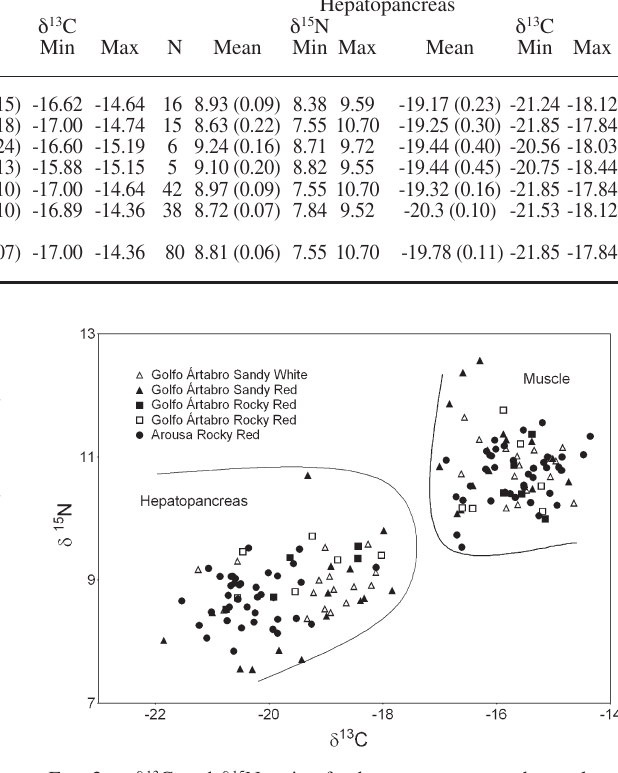
Fig . 2. – δ 13 C and δ 15 n ratios for hepatopancreas and muscle of juvenile spider crabs Maja brachydactyl a in the ria de arousa and Golfo artabro. Substrate type of capture area and body colour are indicated. Table 4. – results of anoVas (F-statistic and probability level in parenthesis) used to test differences in δ 15 n and δ 13 C values in the muscle and hepatopancreas of Maja brachydactyla in the Golfo ártabro, between habitats and body colours (df=